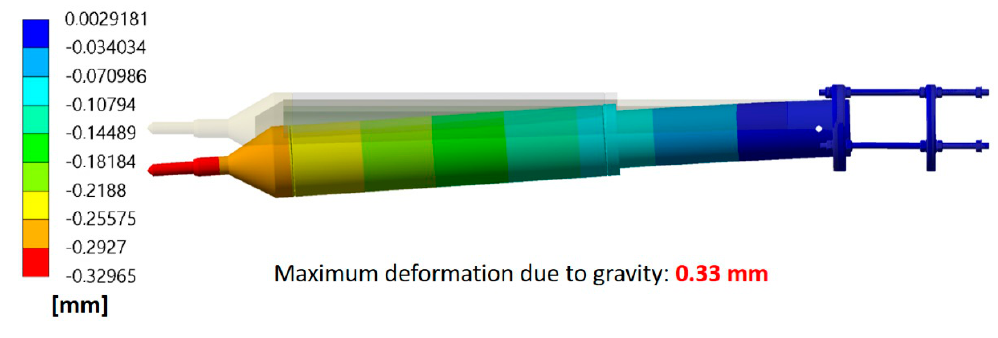
Figure 18. Deformation for one additional stiffening ring (case 1).